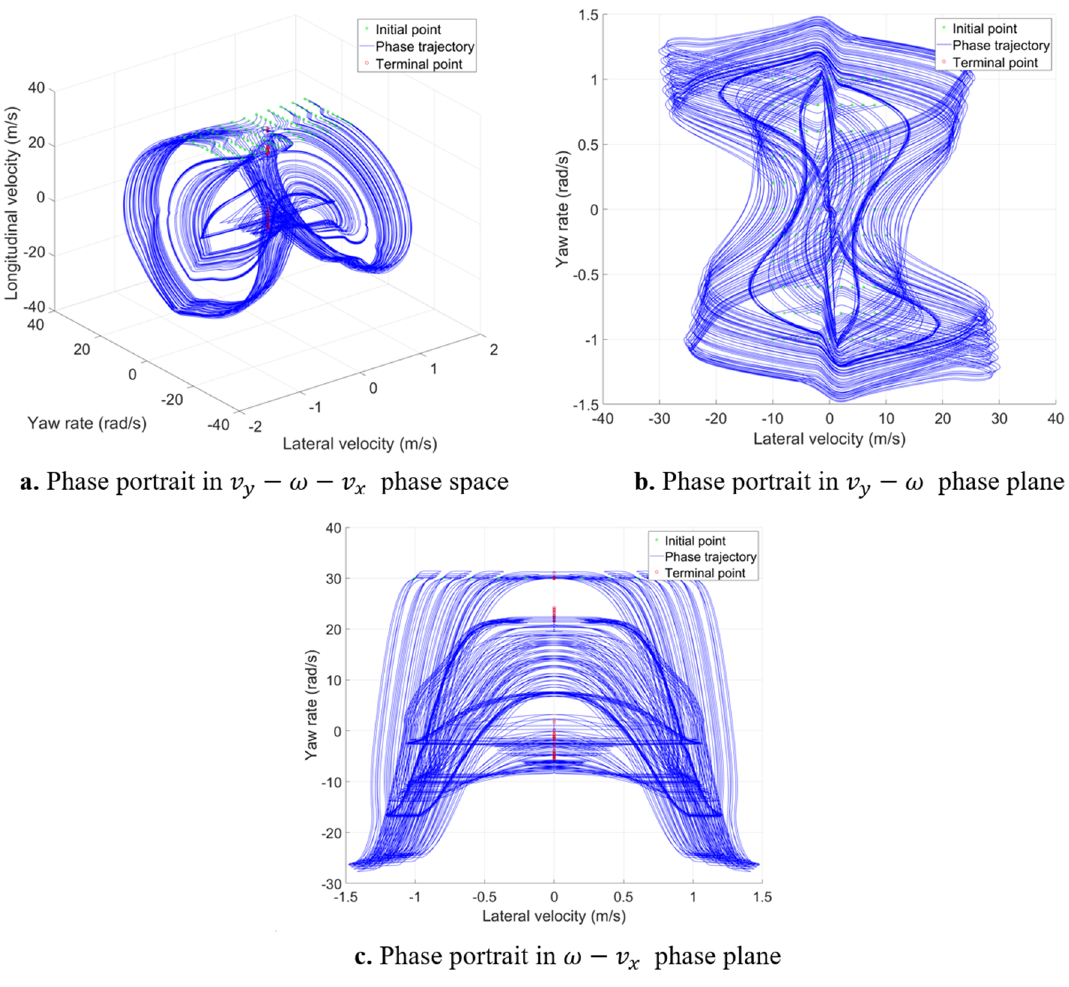
Figure 12. Phase portrait of 5-DOF vehicle